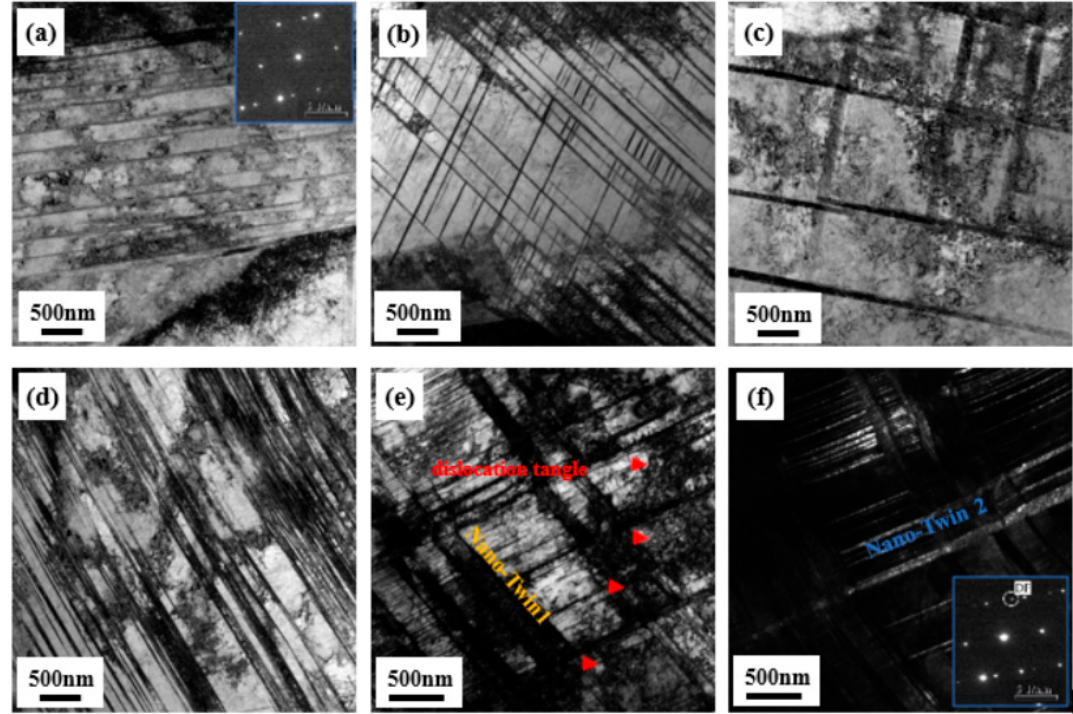
Figure 6. TEM micrographs of the deformed microstructures close to fracture surface of Charpy V-notch impact samples at the FL location and BM, ( a – c ) FL, ( d – f ) BM: ( a ) bright-field image showing nano-twins formed in primary twinning system and ( b , c ) bright-field images showing nano-twins formed in two twinning systems, ( d ) bright-field image showing nano-twins formed in primary twinning system, ( e ) bright-field image and ( f ) corresponding dark-field image showing nano-twins formed in two twinning